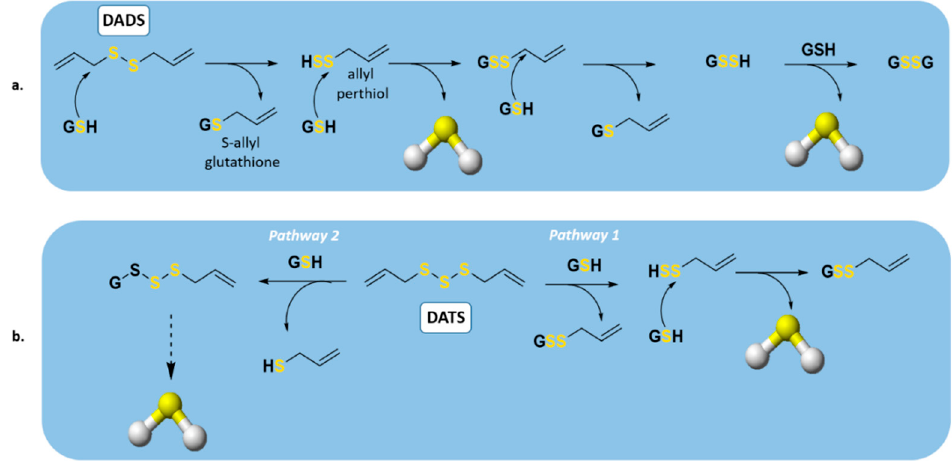
Figure 5. H 2 S production from organic polysulfides by thiol reactions. Proposed mechanism of H 2 S production from ( a ) diallyl disulfide (DADS) and ( b ) diallyl trisulfide (DATS). production from ( a ) diallyl disulfide (DADS) and ( b ) diallyl trisulfide